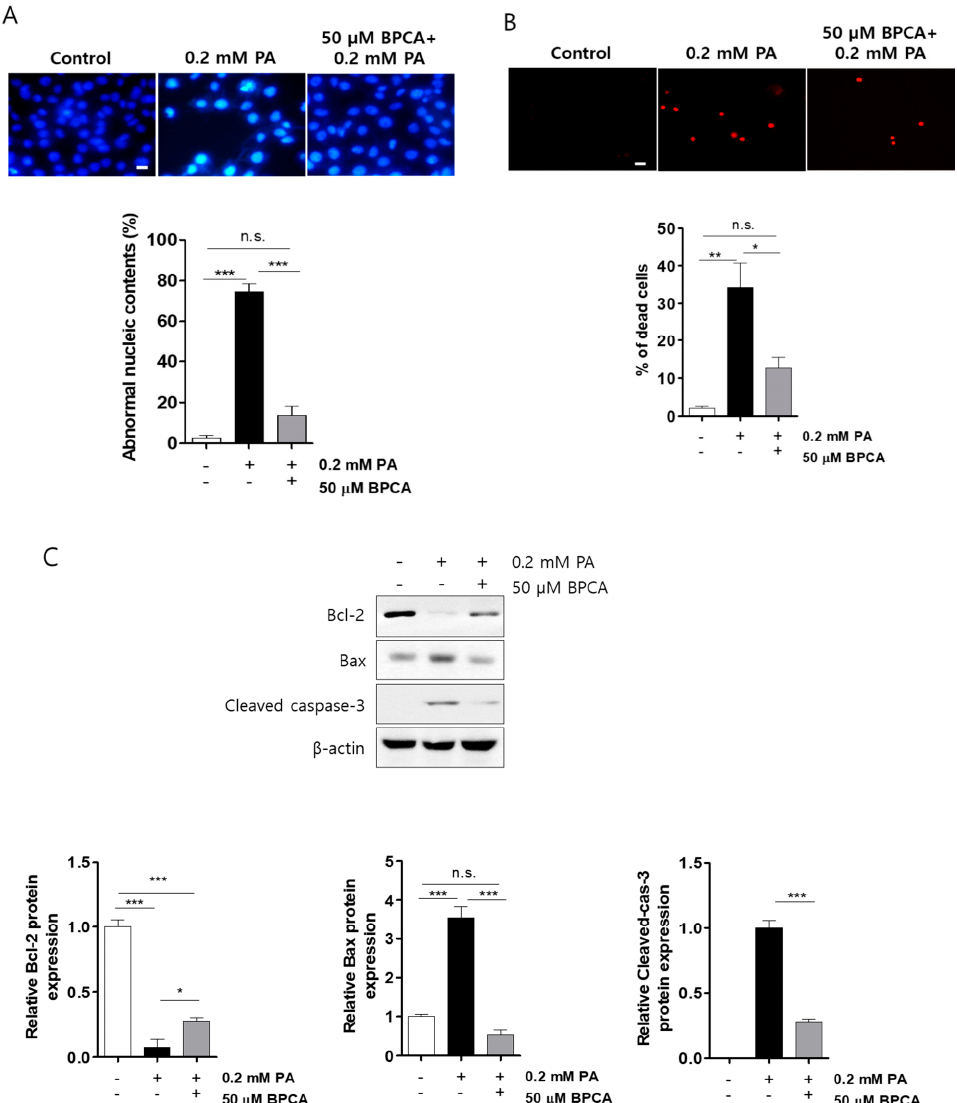
Figure 2. 5-Bromoprotocatechualdehyde (BPCA) isolated from Polysiphonia japonica protects PA-induced cell death in Ins-1 cells. Ins-1 cells were incubated with 50 μ M BPCA for 1 h and then further incubated with/without 0.2 mM PA for 24 h. ( A ) Further incubation with Hoechst 33342 (HO342, 10 μ g/mL) subsequently performed in the images. ( B ) Further incubation with propidium iodide (PI, 50 μ g/mL) subsequently performed in the images. Scale bar: 10 μ m. ( C ). Western blotting was subsequently performed as described in “Materials and Methods”. * p < 0.05, ** p < 0.01, *** p < 0.001, n.s. = no significance.